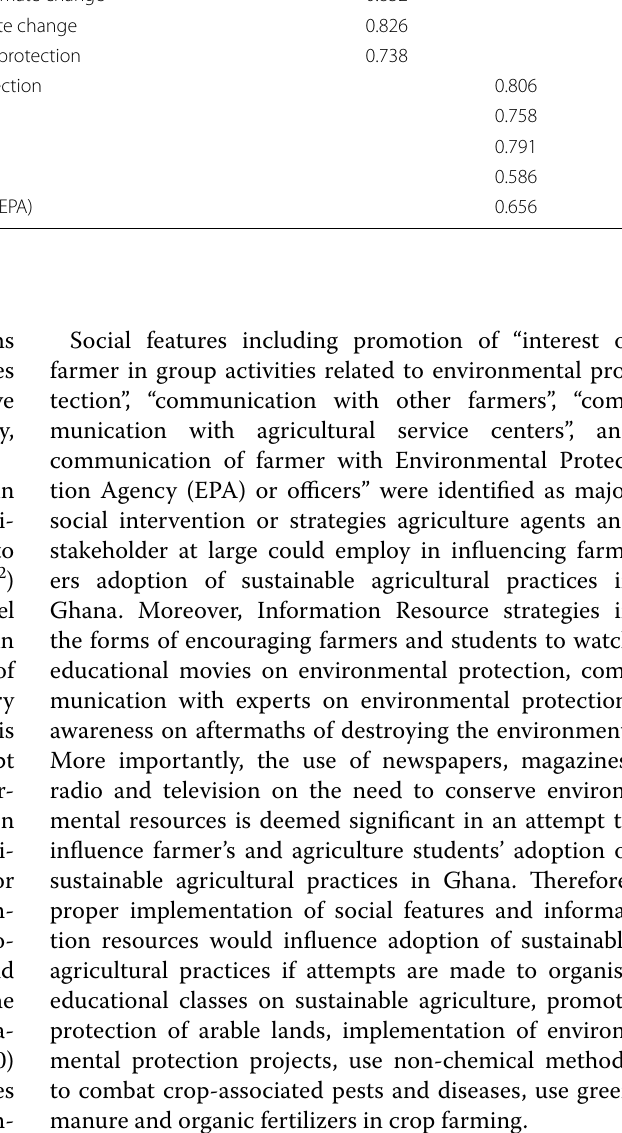
Source: Field survey